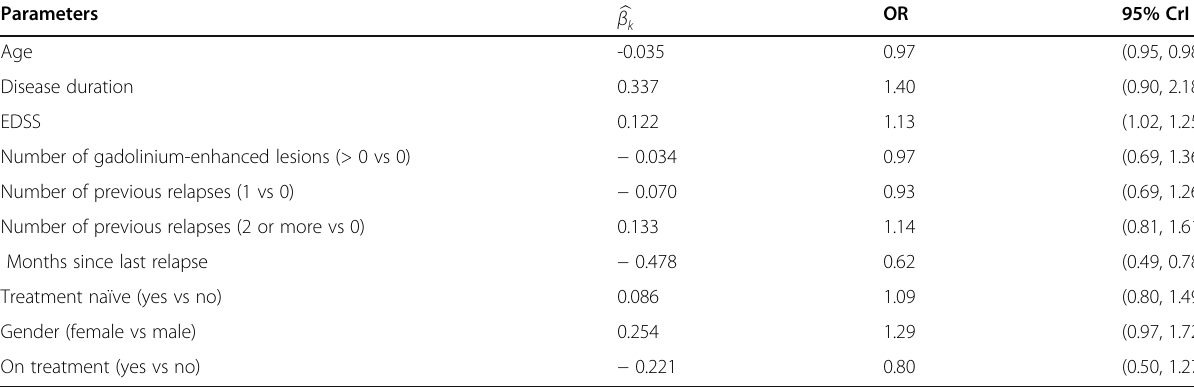
c β ; ORs and the 95% CrIs for each one of the parameters in the model Table 2 Pooled estimates of the regression coefficients k (centralized to the mean), using Rubin ’ s rules. The estimated σ (standard deviation of the impact of the variables on multiple observations for the same individuals) is 0.01. The estimated correlation ρ between the effects of the variables is 0.49. The pooled optimism-corrected AUC is 0.65 and the pooled optimism-corrected calibration slope is 0.91. Disease duration was transformed to log(disease duration+10), and months since last relapse was transformed to log(months since last relapse+10)